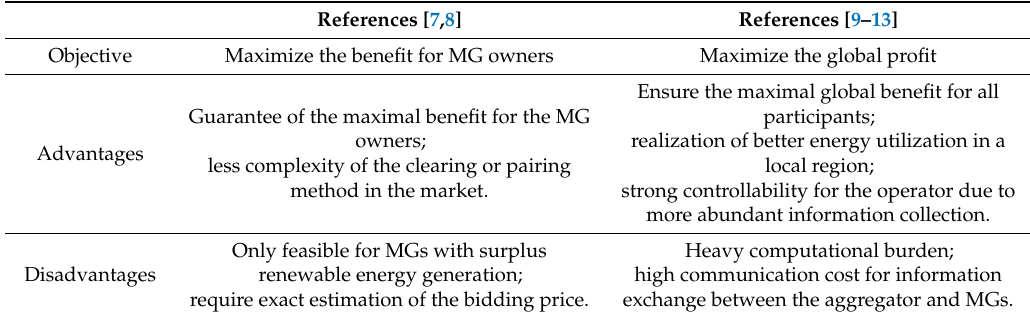
Table 1. Advantages and disadvantages of the existing power sharing methods of multiple microgrids